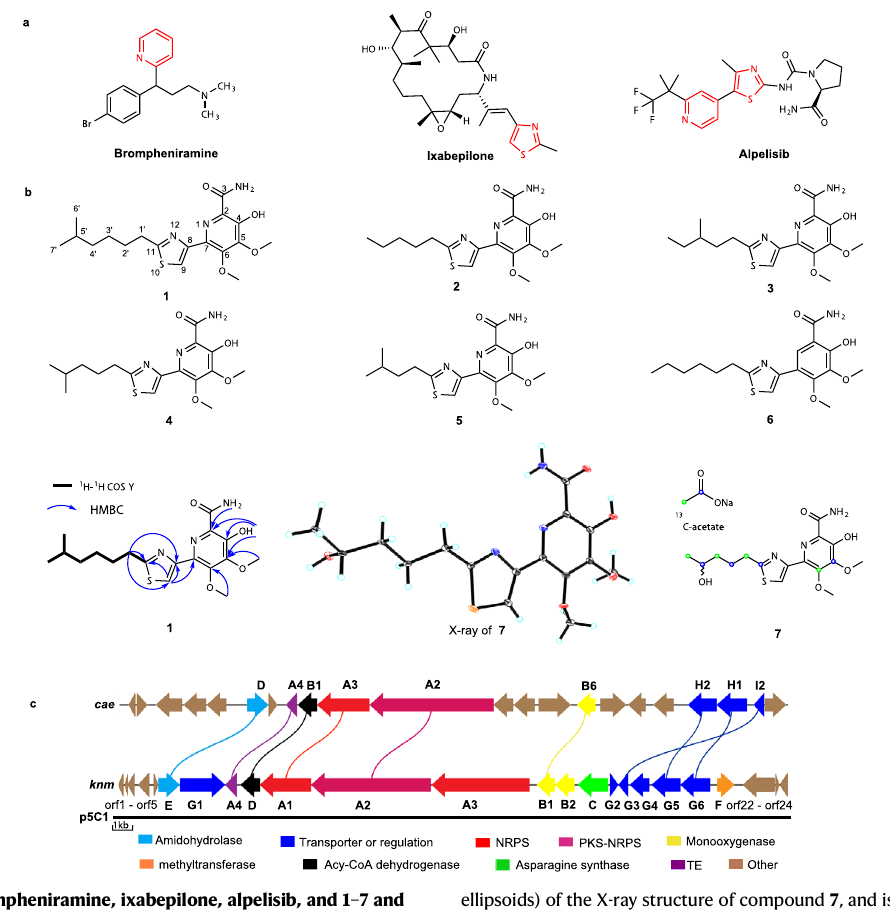
ellipsoids) of the X-ray structure of compound 7 , and isotope labeling result. c Comparisonoftheorganizationofthe cae BGCfrom A.cyanogriseus strainNRRL B-2194 and knm BGC from L. rhizosphaerae